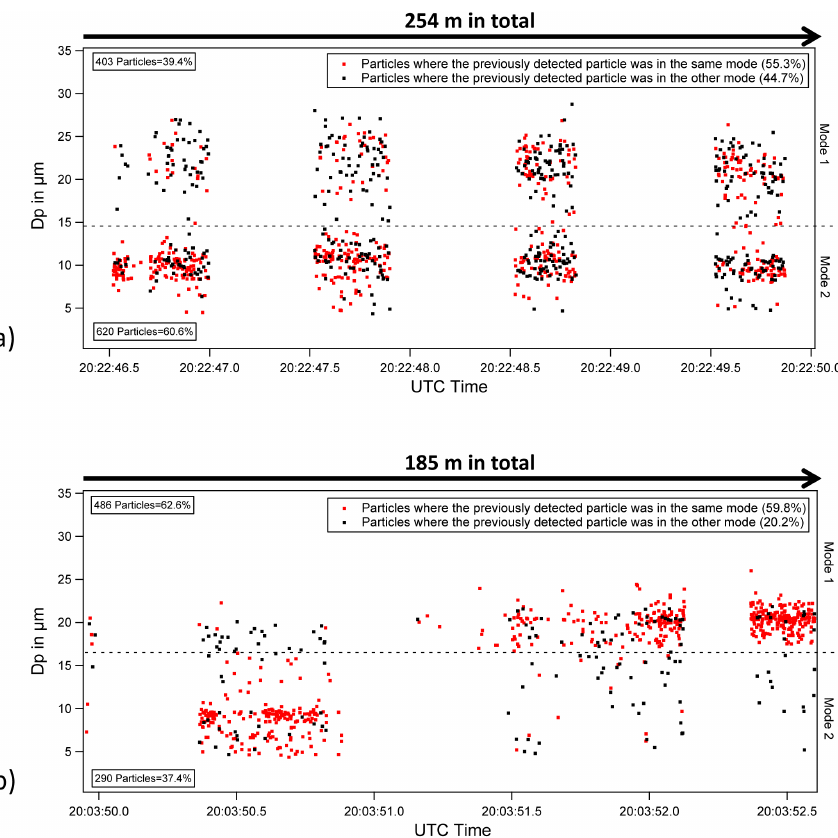
Figure 8. Time slice of Flight 11 on15 May 2012 with particle-by-particle (PbP) data: the detected particles are separated in Mode 1 and Mode 2. The red points mark particles where the previous detected particle was in the same mode. Black points mark particles where the previous detected particle was in the other size mode. (a) represents a good mixing behavior and more particles (60.6%) were detected in Mode 2. (b) indicates a clustered case where most of the particles are in Mode